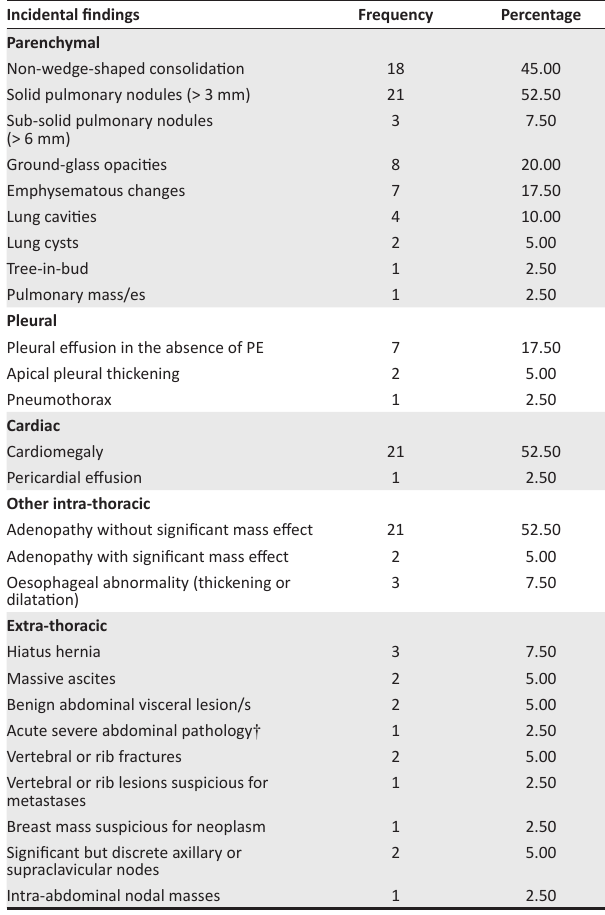
TABLE 3 : Incidental findings on CTPA for HIV-infected patients referred for suspected pulmonary thrombo-embolic